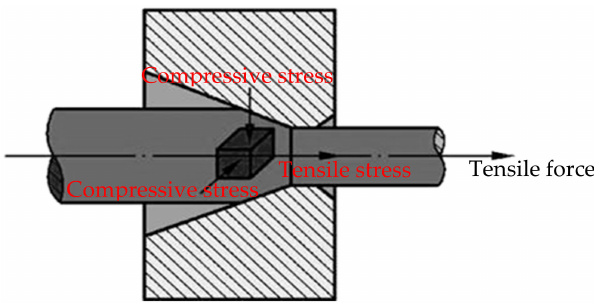
Figure 12. Schematic representation of drawing deformation process of wire electrode.